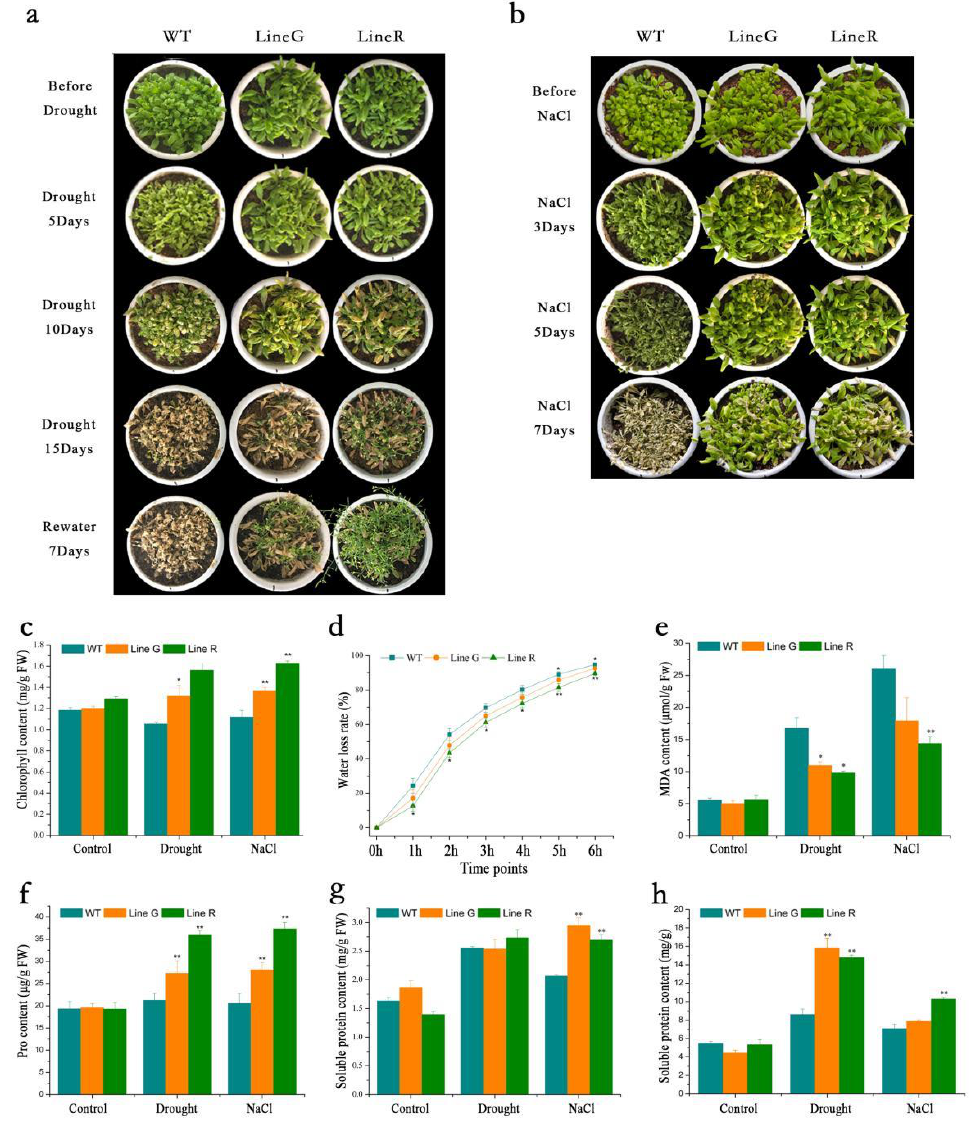
Figure 3. Evaluation of drought and salt tolerance and tolerance-related physiological and biochemical parameters at adult stage. ( a , b ) Indicates growth performance under drought and salinity treatments. ( c – h ) Shows measurements of tolerance-related physiological and biochemical parameters. Data are presented as mean and SD values of three independent experiments. Asterisks indicate significant difference (* p < 0.05, ** p < 0.01, by independent sample t -test) between WT and OE lines. In ( d ), the upper and lower asterisks indicate significant difference between WT and line G and between WT and line R, respectively.